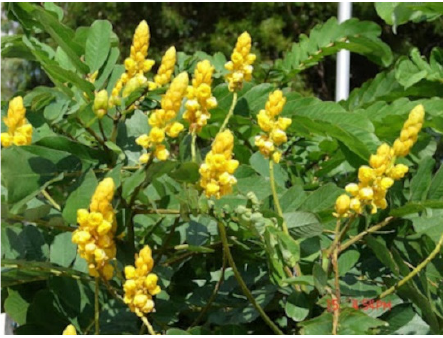
Figure 1. Cassia alata plant.